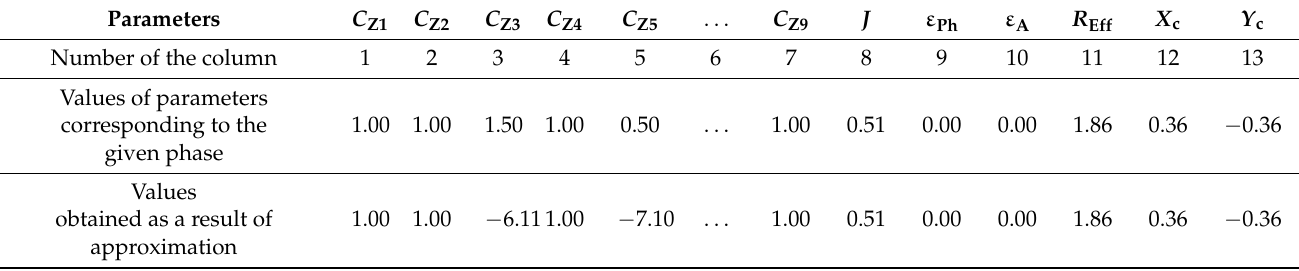
Table 1. The screen was set by 9 polynomials and approximated by 12 polynomials. Dimensions of computational grid are 256 × 256 nodes.